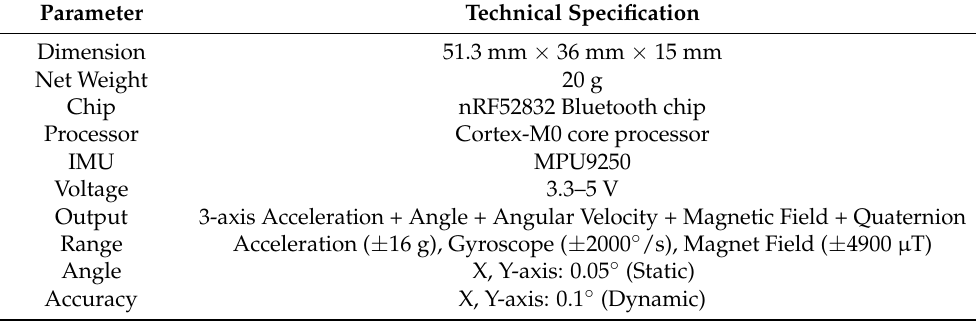
Table 1. IMU specifications. Source: https://www.wit-motion.com/. Accessed on 5 September 2022.